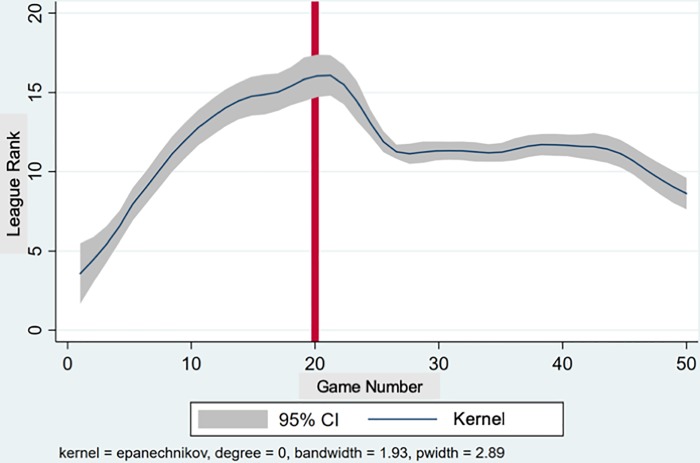
Evolution of league table position over the season (higher number represents worse rank).Note: Kernel (regression line) is a weighted local polynomial smooth regression. CI = confidence interval.